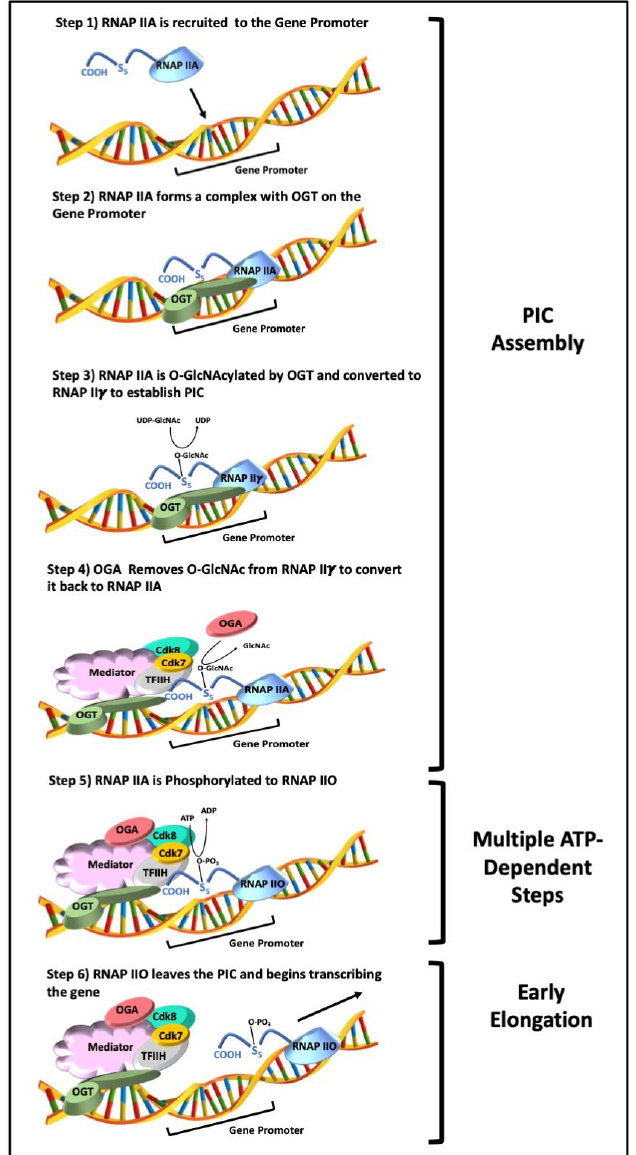
Figure 2. O-GlcNAc cycling and RNAP II-mediated transcription. Model demonstrating how O- GlcNAc cycling regulates various steps of RNAP II transcriptional initiation. In this model, RNAP IIA (unmodified) is recruited to gene promoters by basal transcription factors and core promoter elements (Step 1). RNAP IIA then interacts with OGT (Step 2) and is then O-GlcNAcylated, generating RNAP II γ (Step 3). OGT may be part of the basal transcription factors at the core promoter elements or is recruited to these cis -regulatory elements after RNAP IIA is bound. O-GlcNAcylation of RNAP II, and possibly other basal transcription proteins, lead to the formation of the PIC. OGA associates with the PIC to convert RNAP II γ back to RNAP IIA (Step 4). Finally, RNAP IIA is phosphorylated to generate RNAP IIO (Step 5). RNAP IIO is released from the PIC to initiate transcription (Step 6). Functionally, O-GlcNAcylation of the RNAP II CTD may regulate PIC assembly, tran- scriptional pausing, and elongation in several possible ways. First, O-GlcNAcylation prevents phosphorylation by impeding access of kinases to the necessary serine and threo- nine residues of the CTD. Phosphorylation of these amino acid residues are required for RNAP II to dissociate from the PIC and critical for mRNA processing and transcription cycle progression. Second, O-GlcNAc addition and removal may promote or impede protein-protein interactions required for PIC assembly, transcriptional pausing, and